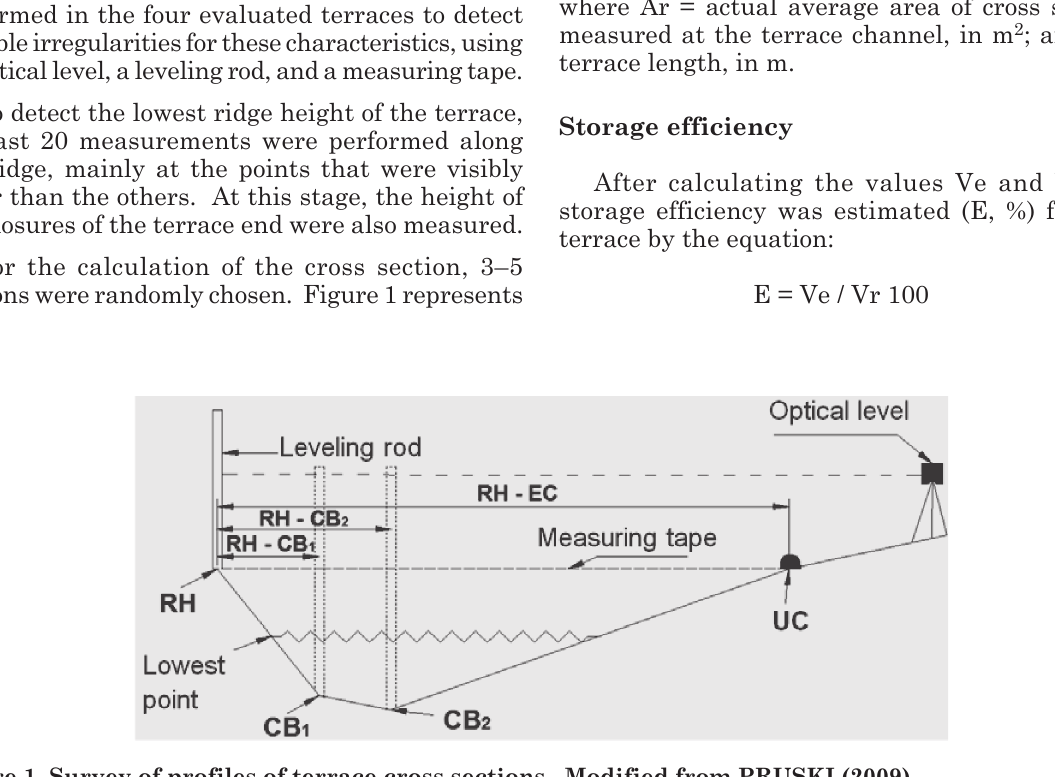
figure 1. survey of profiles of terrace cross sections. modified from PRusKi